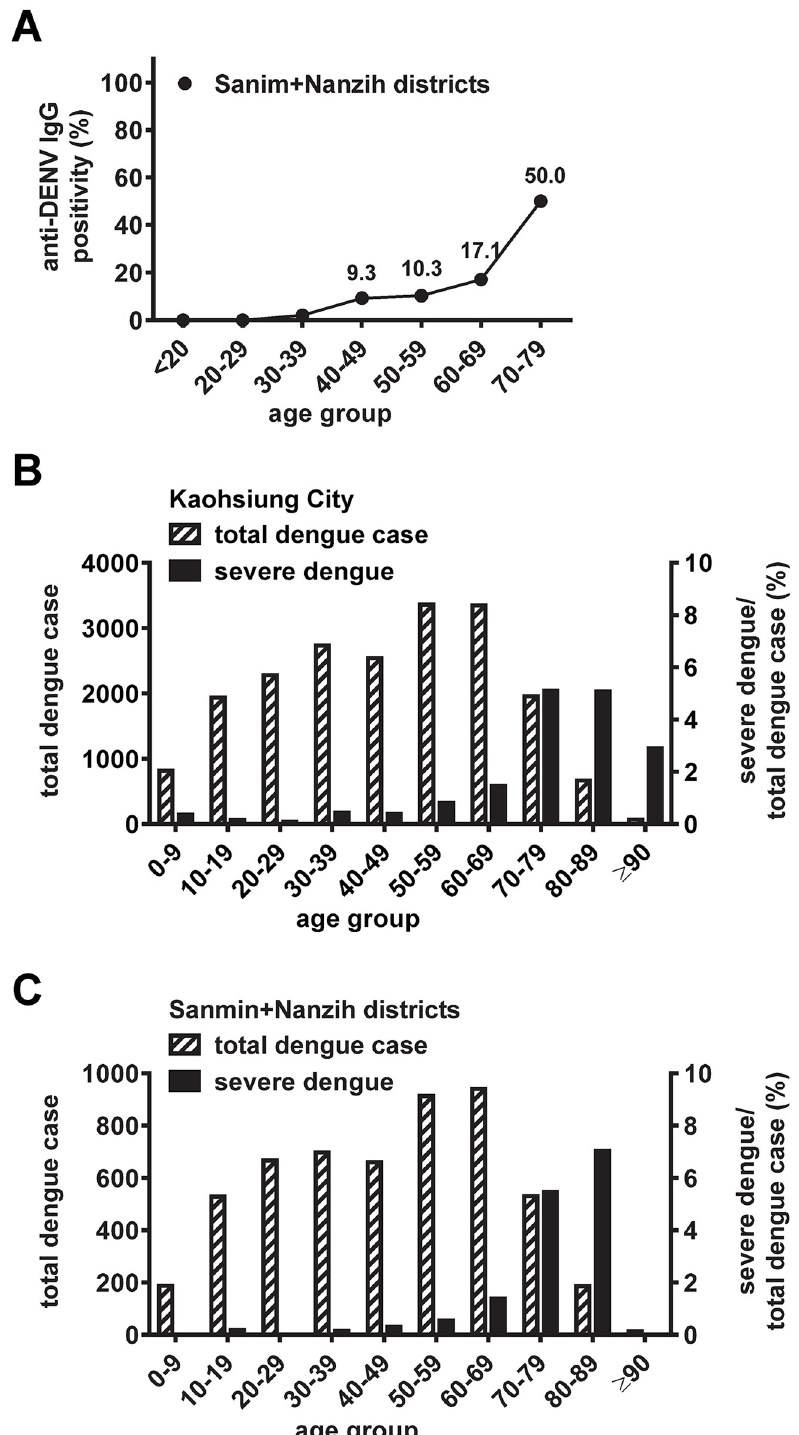
Fig 3. Age-specific DENV seroprevalence in two districts of Kaohsiung City in comparison with dengue cases and proportion of severe dengue. (A) DENV seroprevalence was based on the InBios DENV detect IgG ELISA; data in the 80–89 y/o group were not included due to the small number of participants. (B,C) The numbers of age-specific confirmed indigenous dengue cases and proportion of severe dengue among total dengue cases in each age group in Kaohsiung City (B) and in both Sanmin and Nanzih districts (C) were based on data from CDC Taiwan [18].